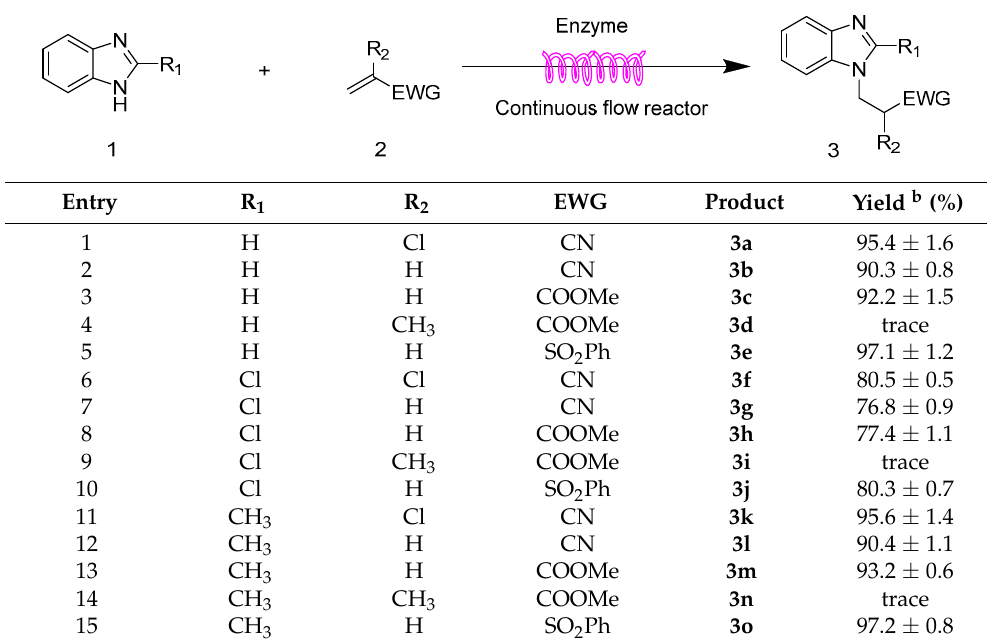
Table 2. Continuous process for the synthesis of N-substituted benzimidazole derivatives catalyzed by lipase TL IM from Thermomyces lanuginosus in continuous-flow microreactors a .